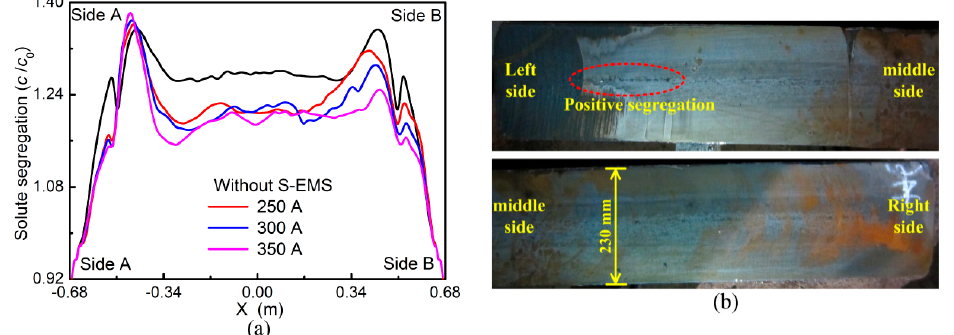
Figure 9. Solute segregation distribution along the transverse direction ( a ) and the etched macrostructure of slab with current set at 350 A ( b ).